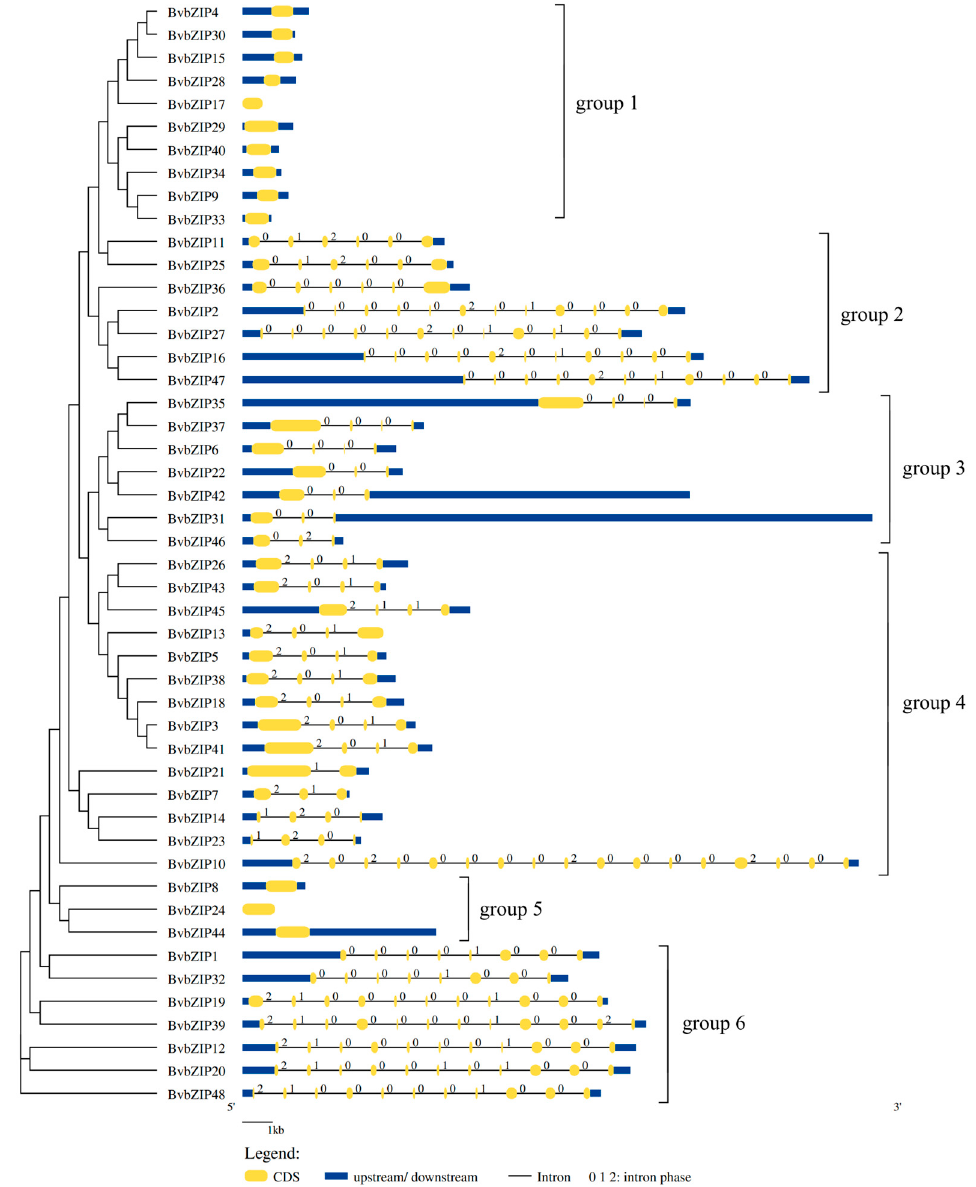
Figure 1. Gene structures of BvbZIP genes. Yellow boxes represent exons, black lines represent introns, blue boxes represent upstream and downstream noncoding regions, and the numbers 0, 1 and 2 represent intron phases. The BvbZIP genes were divided into groups 1 to 6 according to the intron phase, and the grouping results are consistent with the evolutionary tree structure of the BvbZIP